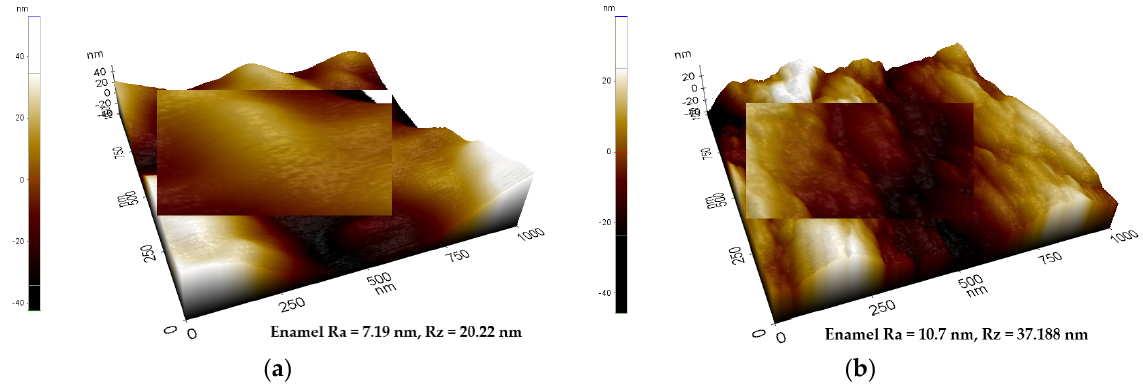
Figure 3. AFM image—Three-dimensional appearance of the enamel structure. The variability of the roughness profile can be observed at the enamel level. ( a ) X Scan Size 1 micrometer, Y Scan Size 1 micrometer, Ra = 7.19 nm, Rz = 20.22 nm; ( b ) X Scan Size 5 μ m, Y Scan Size 5 μ m, Ra = 10.7 nm, Rz = 37.188 nm.